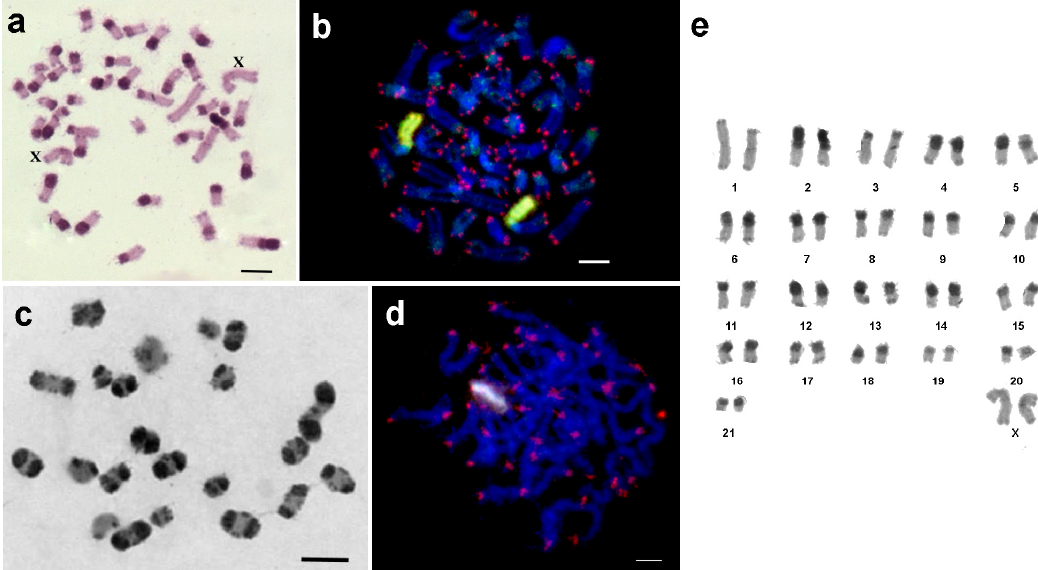
Figure 6. Mitotic and meiotic chromosomes of Peruphasma schultei ; ( a ) C-banding of embryonal metaphase chromosomes. The X chromosomes are labeled with ‘X’. ( b ) FISH as in Figure 1b. ( c ) C-banding of adult male derived meiotic chromosomes. ( d ) FISH on meiotic chromosomes (pachytene), using probes as given in Figure 1b. Scale bar indicates 5 μ m; ( e ) Female P. schultei have 22 chromosome pairs and a karyotype 21,XX.